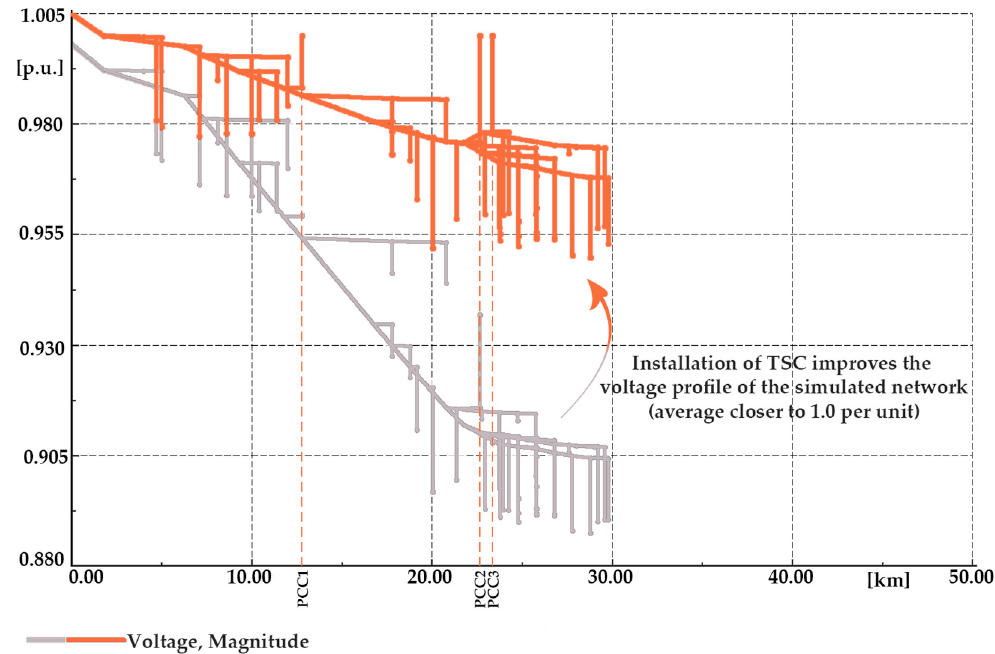
Figure 6. DIgSILENT Power Factory simulation results—network voltage profile without SVC (gray) and with implemented SVC (orange) on PCC1, PCC2 and PCC3 busbar.